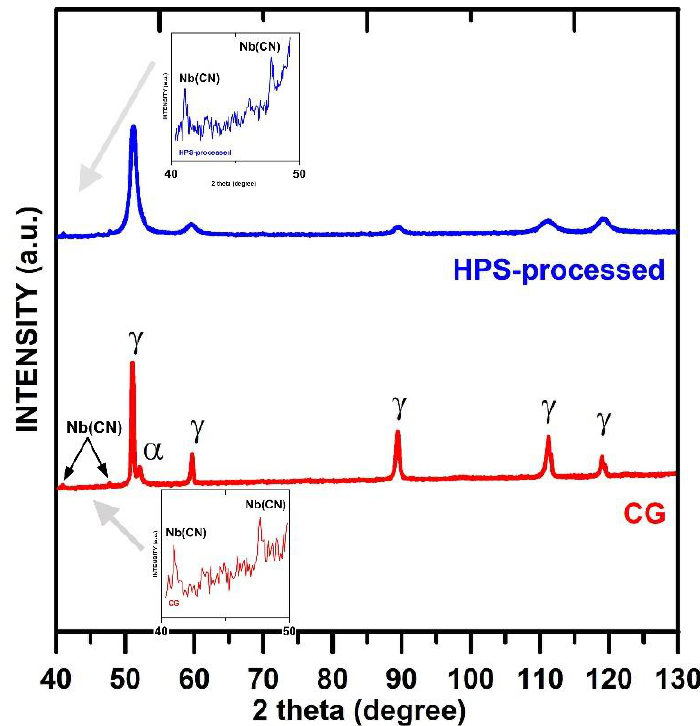
Figure 1. X-ray diffractograms obtained for coarse-grained and HPS-processed S304H steel.